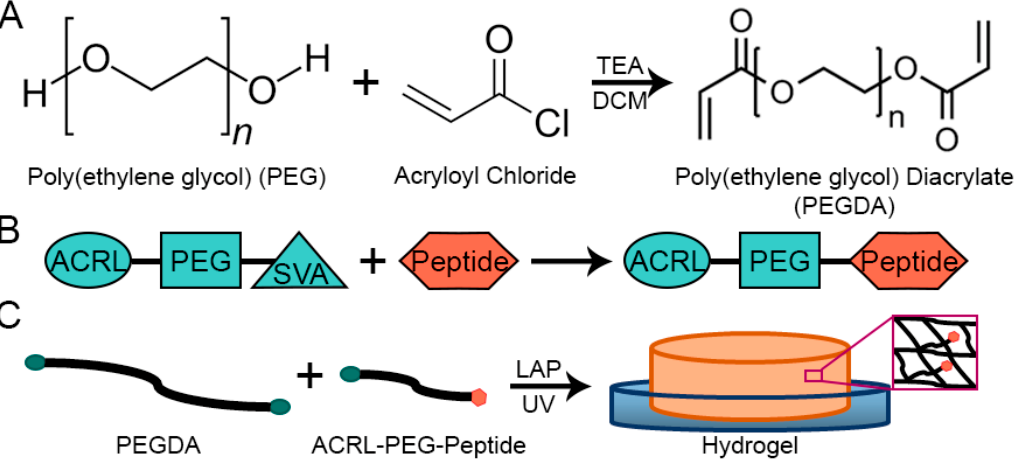
Figure 1. ( A ) Schematic representation of the end-group modification of PEG. ( B ) Schematic repre- sentation of the conjugation of peptide sequences to a PEG-based linker, and ( C ) illustration of the incorporation of conjugated peptides into a PEGDA-based hydrogel using photopolymerization.